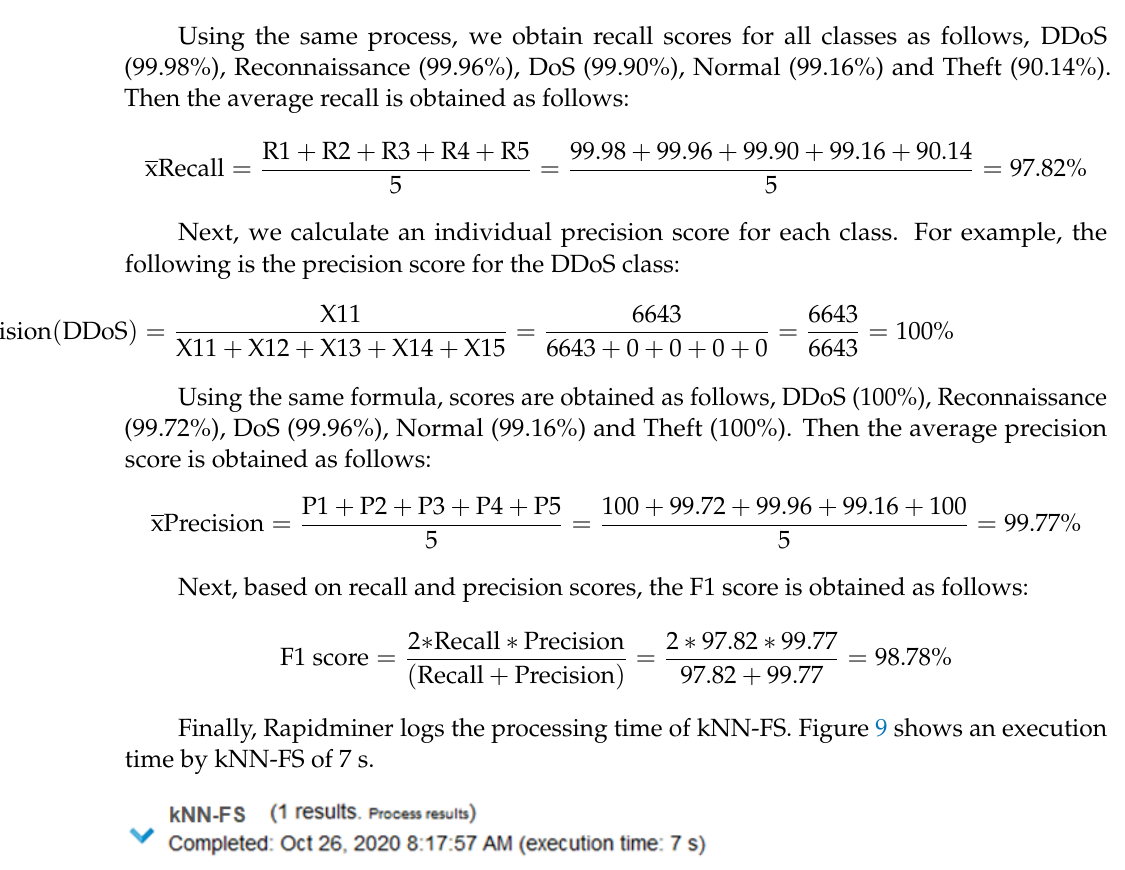
Figure 9. Execution time for kNN-FS.